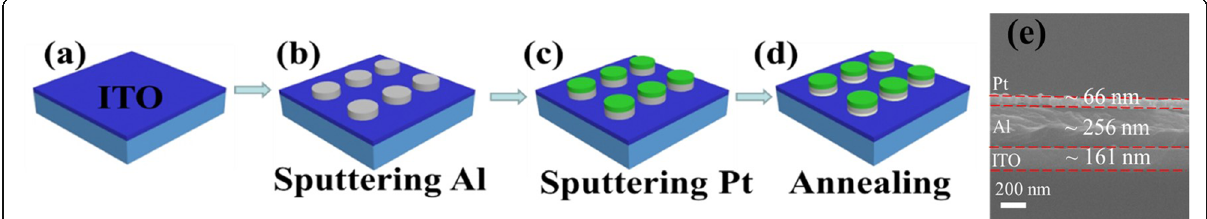
Fig. 1 A schematic diagram of the fabrication process. ( a ) ITO/glass substrate. ( b ) Deposition of the Al electrode by sputtering. ( c ) Pt covering the Al electrode. ( d ) Formation of the AlO x interface layer by annealing at 400 °C in a vacuum. ( e ) SEM image of the annealed Pt/Al/ITO device. The thicknesses of the Pt, Al and ITO are approximately 66 nm, 256 nm and 161 nm,